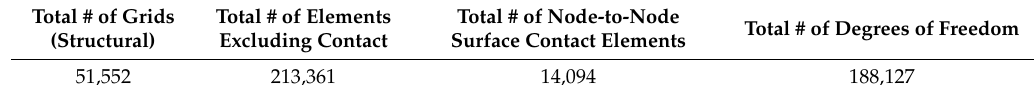
Table 2. Total number of grids (structural), elements excluding contact, node-to-node surface contact elements, and degrees of freedom.